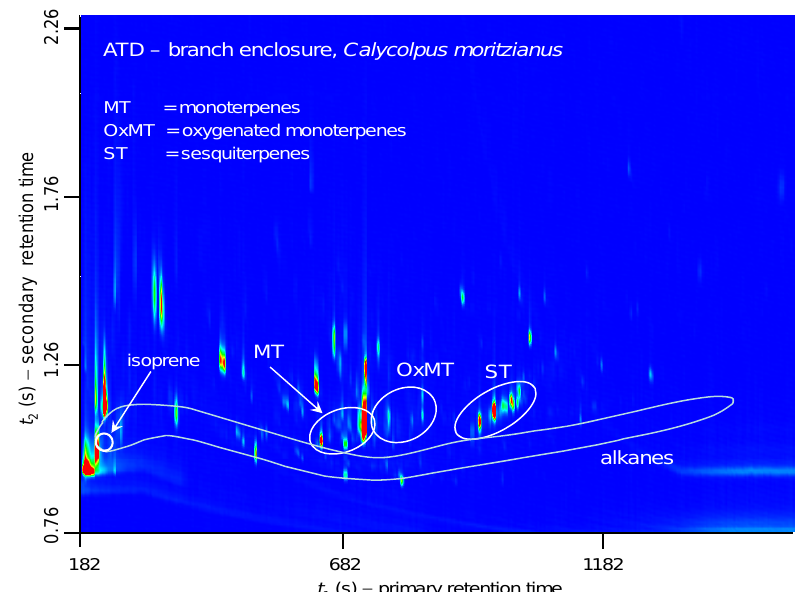
Figure 3. Fig. 3. GC × GC-TOFMS chromatogram of VBOCs from Calycolpus moritzianus by ATD using a branch enclosure in the field; obtained using the “initial” chromatographic conditions (Table 3).